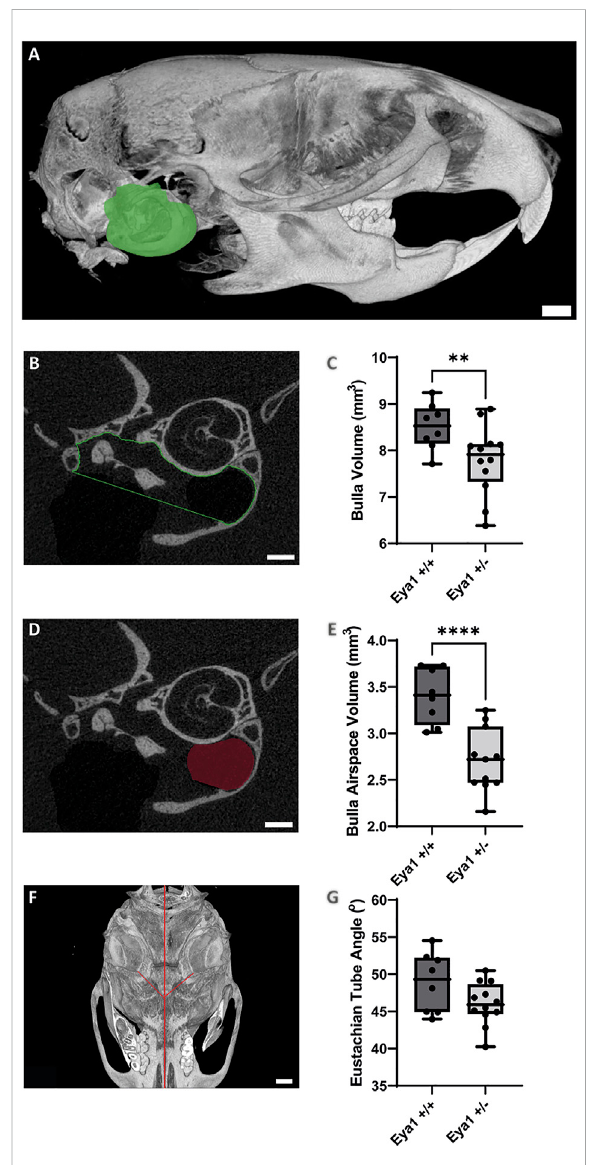
FIGURE 2 MicroCT analysis highlights smaller auditory bulla in Eya1